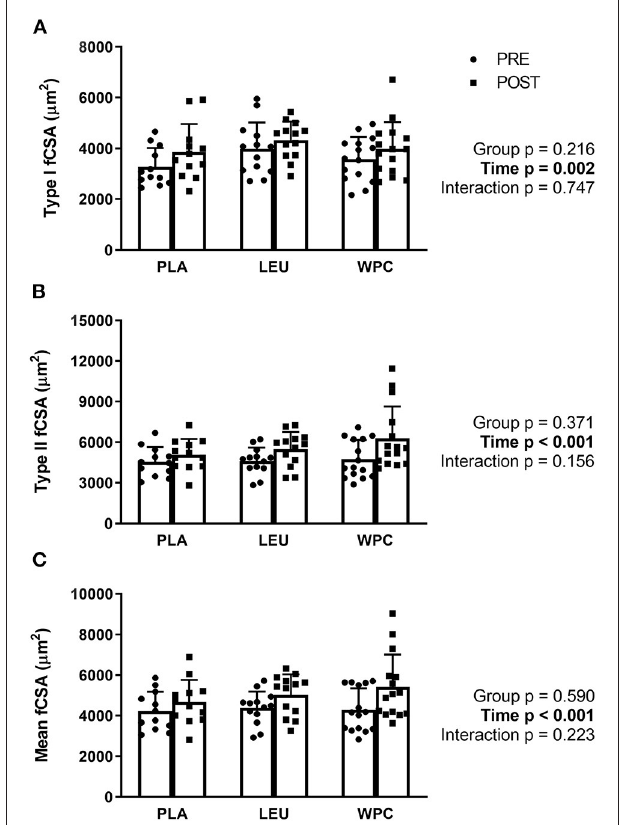
FIGURE 1 | Muscle fiber cross-sectional area (fCSA) increases with resistance exercise training independent of supplementation group. Skeletal muscle type I (A) , type II (B) , and mean (C) fCSA increased following 12 weeks of total-body resistance exercise training independent of consuming placebo (PLA), leucine (LEU), or whey protein concentrate (WPC). Open columns designate pre-training values (PRE), and closed columns designate post-training values (POST). Data are represented as mean ± standard deviation. Sample size for each group is PLA = 12, LEU = 13, and WPC = 15.